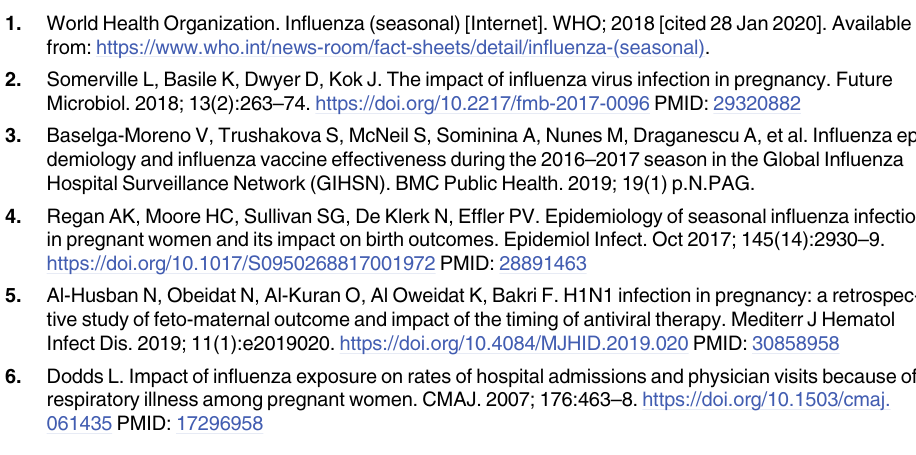
S2 Table. Enhancing Transparency of Reporting the Synthesis of Qualitative Research (ENTREQ) checklist. S3 Table. Example of electronic Boolean search strategy. S4 Table. Characteristics of included studies. S5 Table. CASP checklist for included